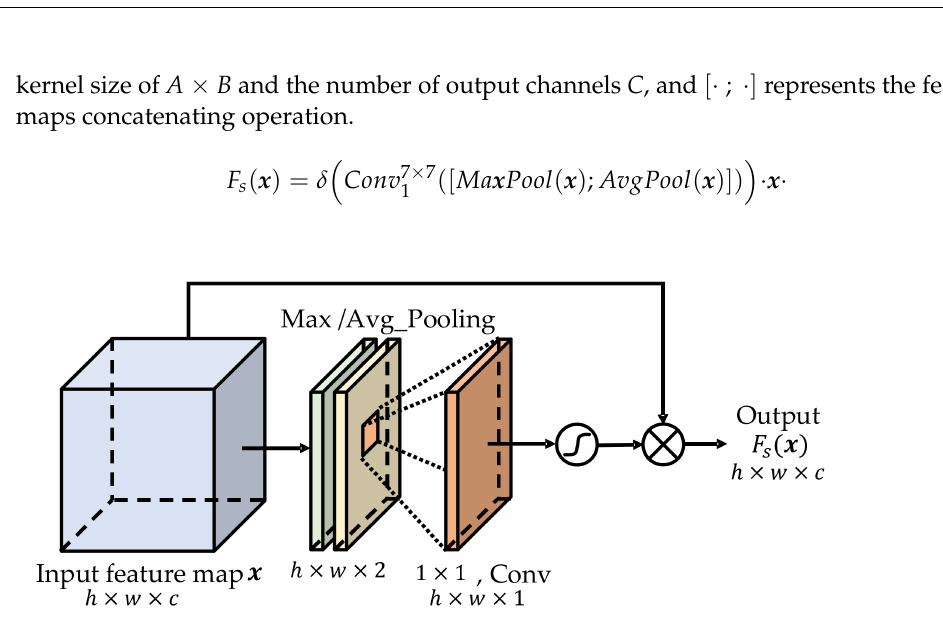
Figure 8. Structure of the spatial attention